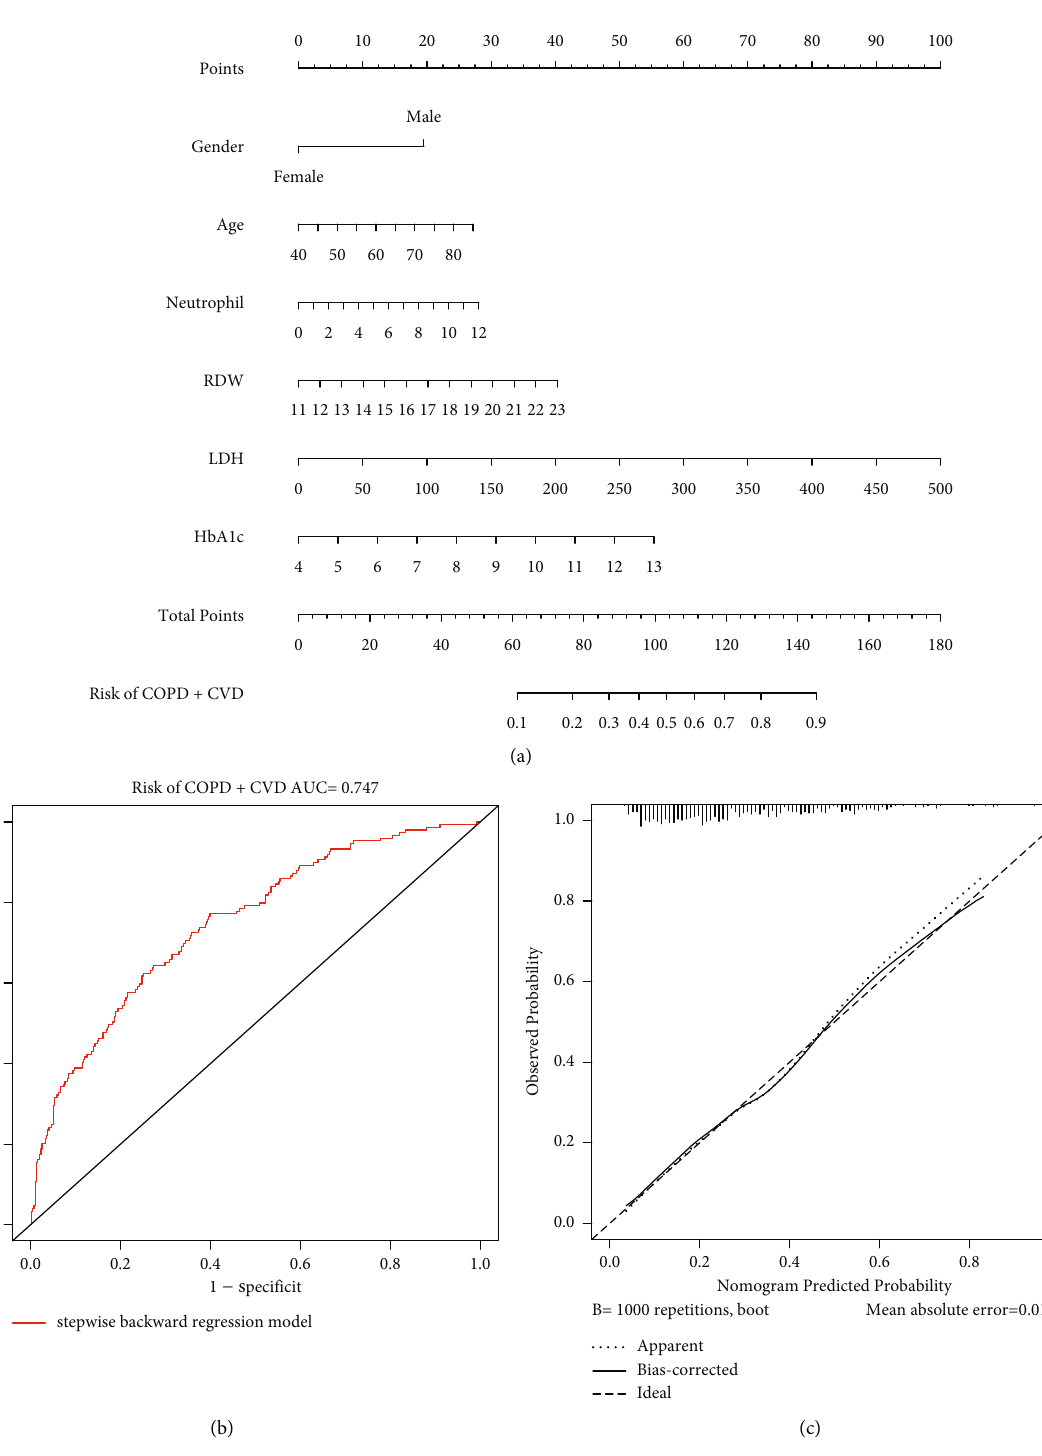
Figure 2: (a) Nomogram showing results of the diagnostic model using gender, age, neutrophil, RDW, LDH, and HbA1c. Each diagnostic factor corresponded to a score, and the total score of an individual patient was obtained by adding the scores of the individual factors, and a straight line was drawn on the axis of the total score to predict the risk of coexisting cardiovascular disease in COPD. (b) The ROC curves for the diagnostic nomogram. (c) The calibration curves of the diagnostic